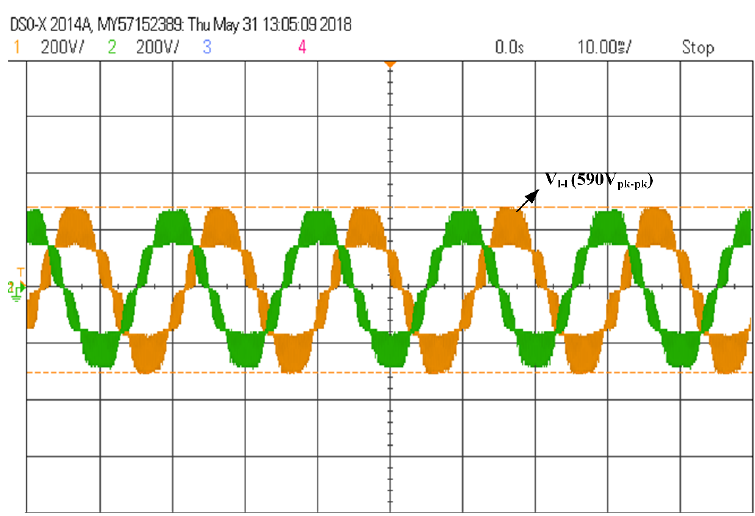
Figure 17. Hardware prototype for the experimental validation.